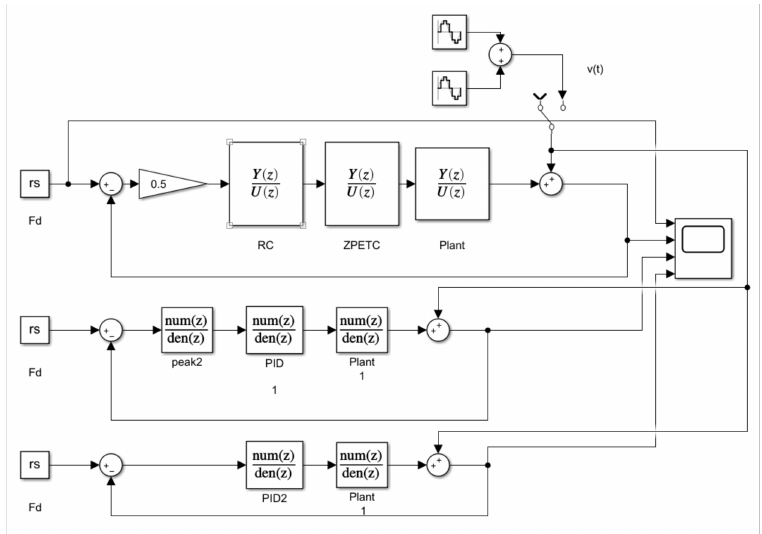
Figure 9. Block diagram of the model built in Matlab ®